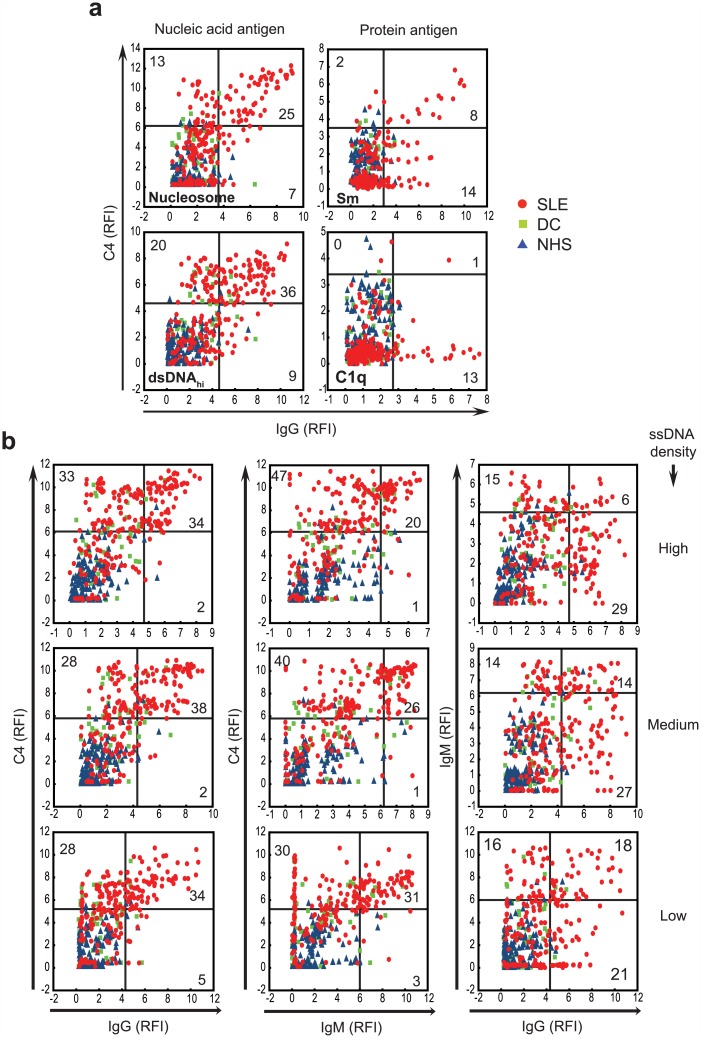
Antibody binding and complement C4 deposition on various antigens.Scatterplots show the relationship between IgG reactivity and C4 deposition in the sera of healthy (NHS), disease control (DC) and SLE subjects. Numbers indicate percentage of SLE subjects in the respective quadrants, which were generated by the 98th percentile boundaries of the NHS group. Antigens of different biochemical nature (a) and of different epitope density (b) are shown. ssDNA, single-stranded DNA